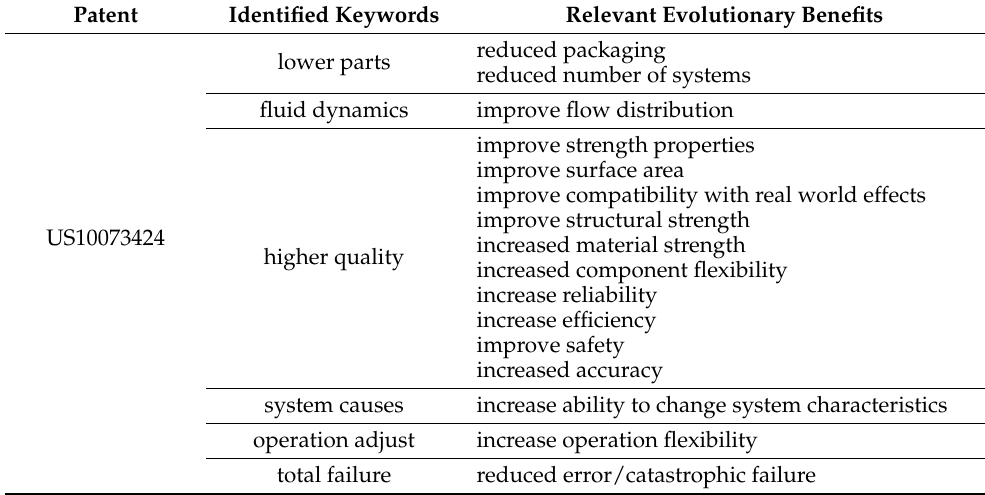
Table 4. The result of similarity comparison for patent US10073424.